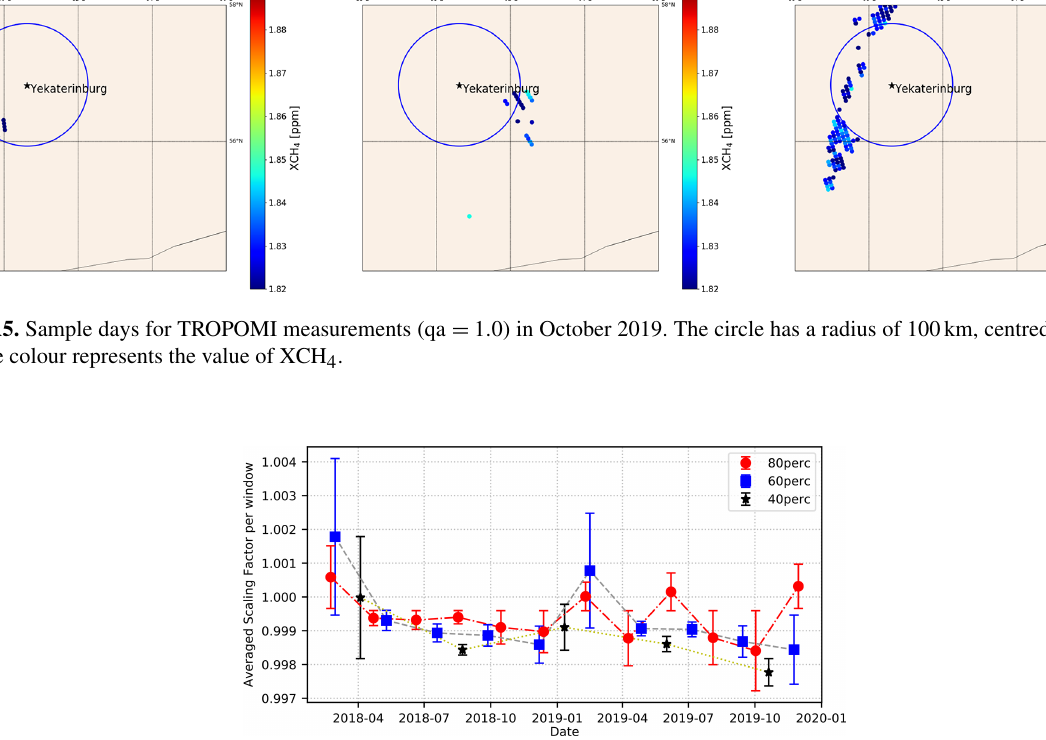
Figure A6. Temporal variation of the averaged scaling factors in each sub-window for the number of windows selected for each subset of COCCON measurements at Karlsruhe (40%, 60% and 80% of the total measurement days with FTS#37). The error bar represents the standard deviation calculated in each sub-window.